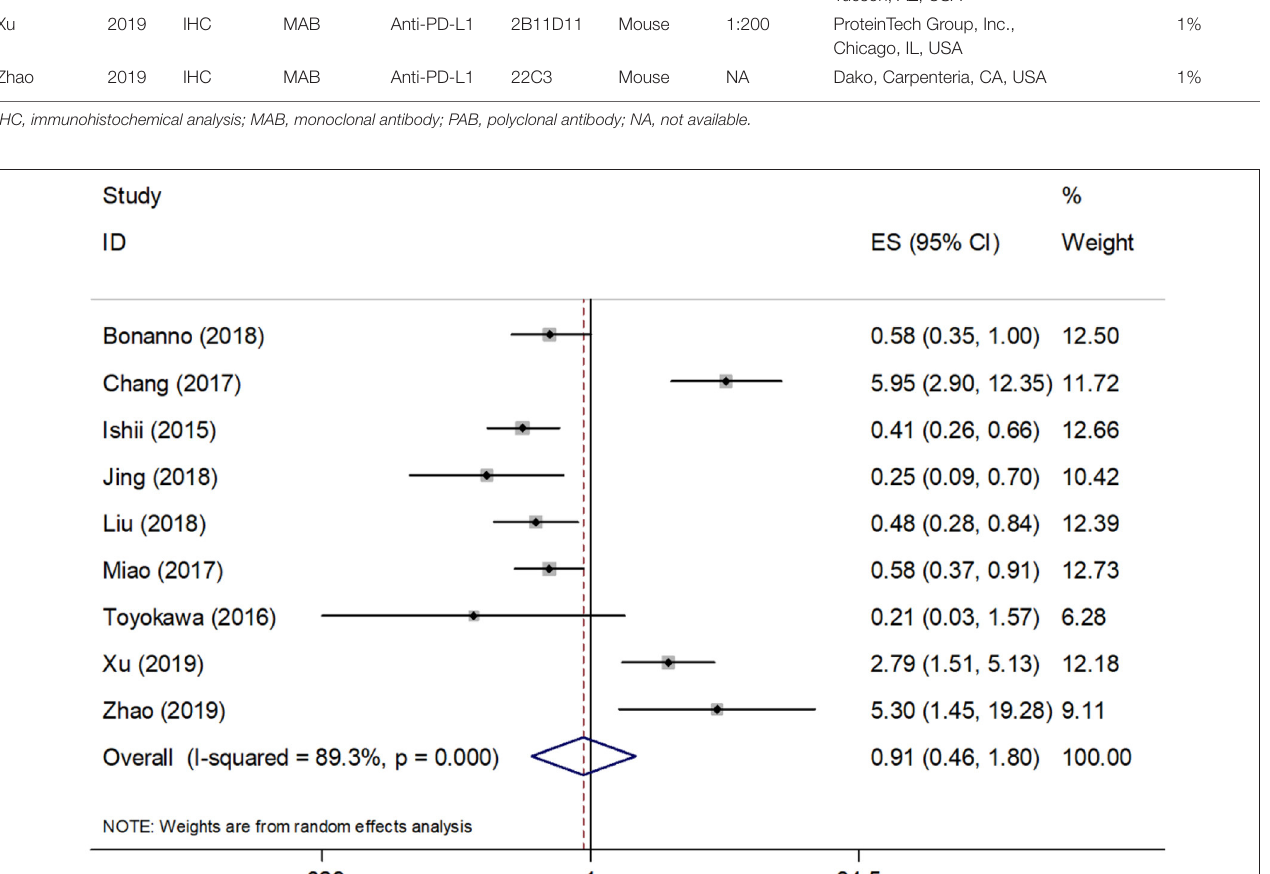
Table 4 . The pooled ORs and 95% CIs demonstrated